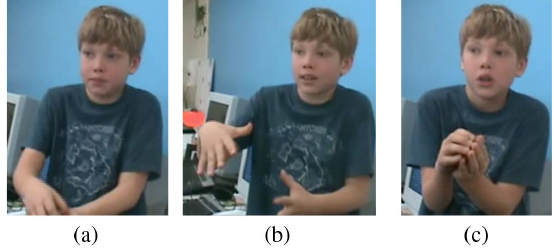
FIG. 1. Jared gestures as he says “ expanded ” (a),(b) and “ packed together ”